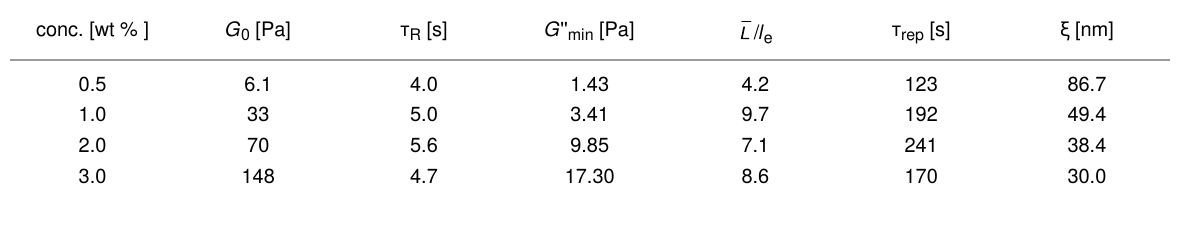
Table 1: Characteristic rheological values of reverse wormlike micelles from the dirhamnolipid ethyl ester 2 /toluene system. conc. [wt %